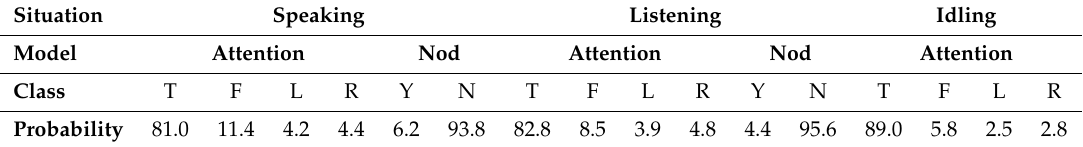
Figure 12. One scene of the video clips used in the subjective evaluation experiment. Table 9. Probability (%) distribution of the statistical